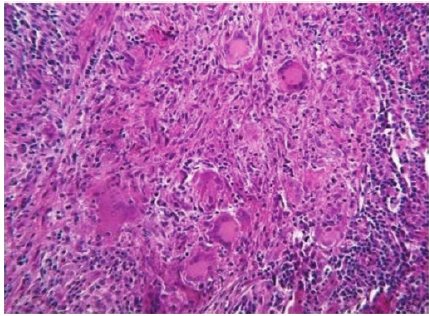
Figure 9: Histologic examination (hematoxylin and eosin × 10). Central giant cell lesions in advanced stages may